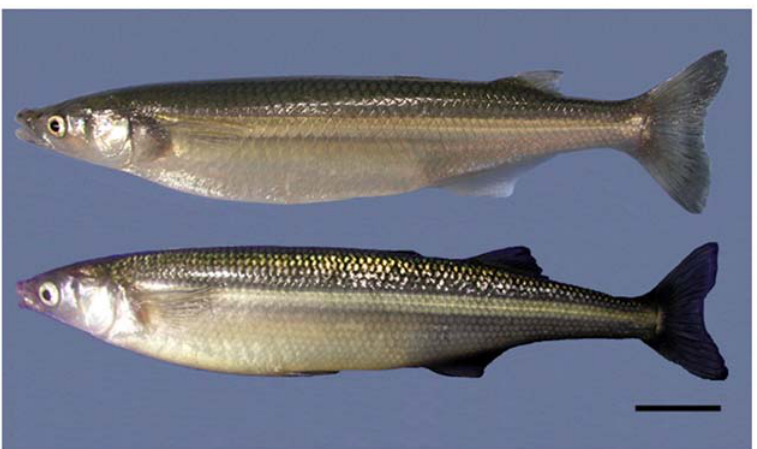
Figure 5. The model fish species used in the study: pejerrey Odontesthesbonariensis (donor; top) and Patagonian pejerrey O.hatcheri (recipient; bottom). Scale bar indicates 4 cm.